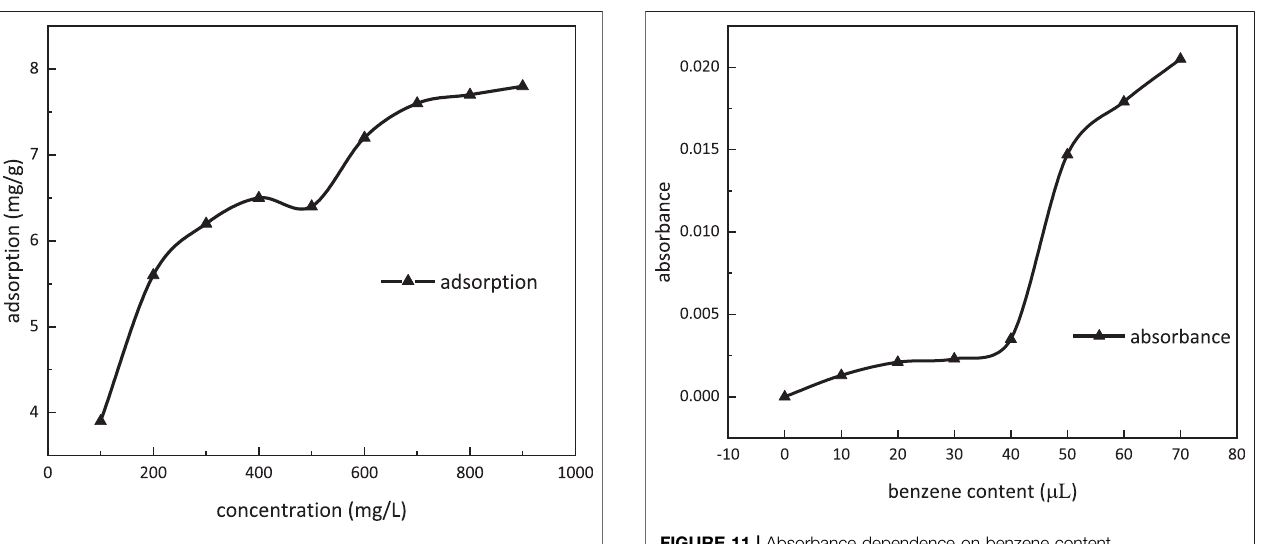
FIGURE 10 | Adsorption dependence on the concentration of m -HPAE.